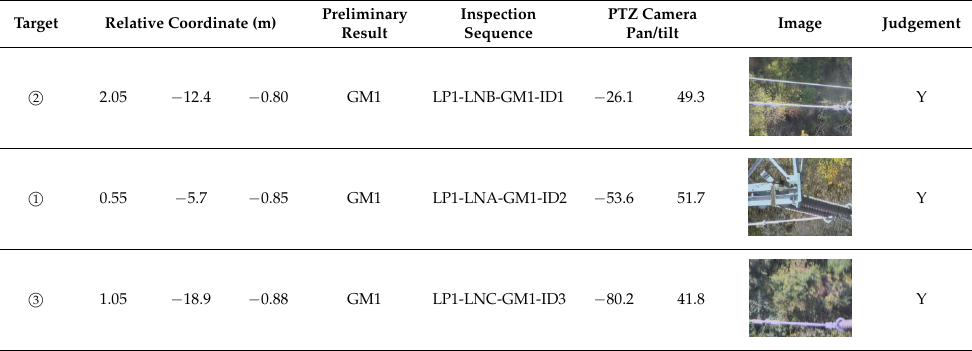
Table 5. Inspection information of targets on three phase conductors.